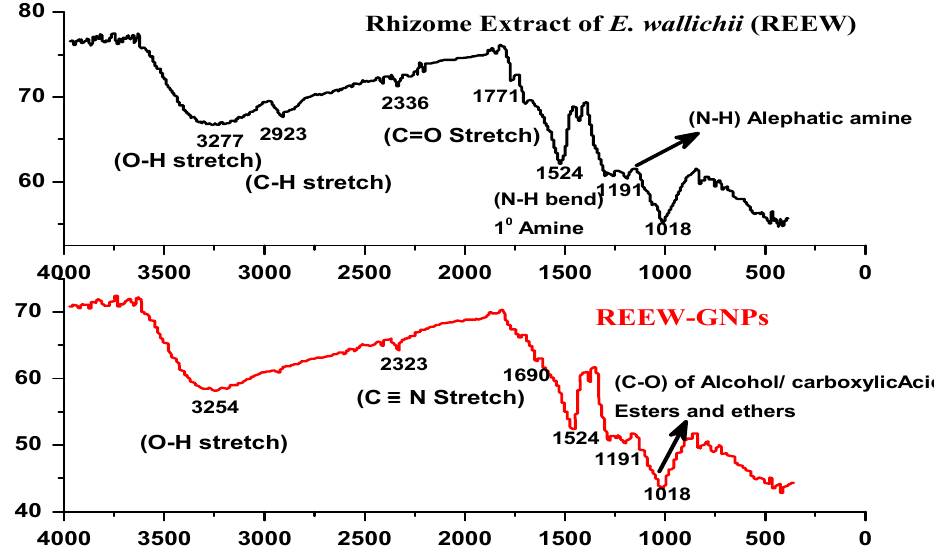
Figure 4. FTIR spectra of REEW and REEW-GNs showing various functional groups correspond to different vibration stretches.